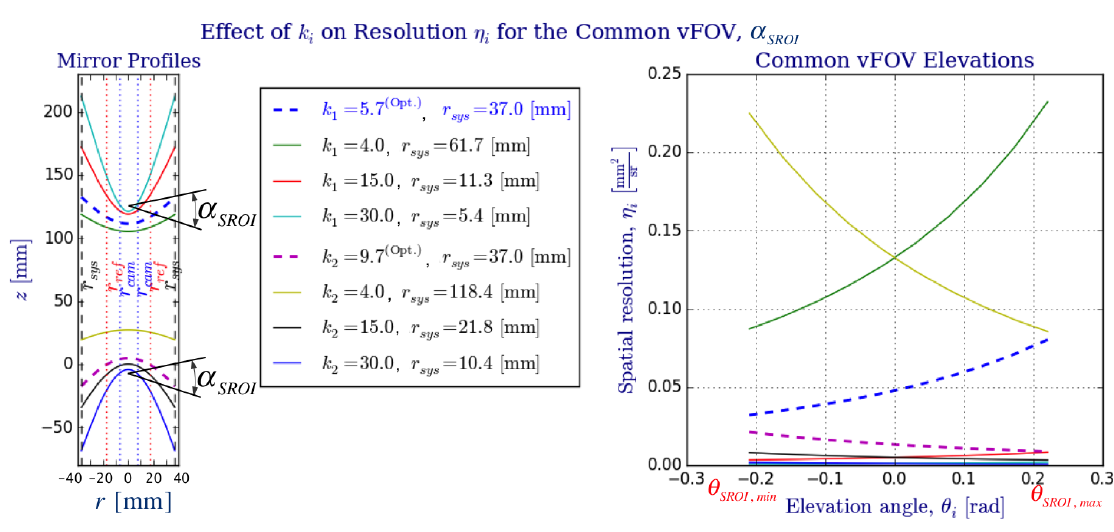
Figure 11. Comparison of k i values and their effect on spatial resolution η i for i = { 1,2 } . For the big rig, the optimal focal dimensions c 1 and c 2 (from Table 1) were used as well as the angular span on ( Opt . ) the common vertical FOV, α SROI ≈ 28 ◦ . Although resolution η for the optimal values of k i could i be improved by employing smaller k values (lower curvature profiles indicated on the left plot of the figure), this would in turn increase the system radius, r sys , as to maintain α i (Figure 9). As expected, the plot on the right help us appreciate how the spatial resolutions, η i , increase towards the equatorial regions ( θ 1 → θ SROI , max and θ 2 → θ SROI , min